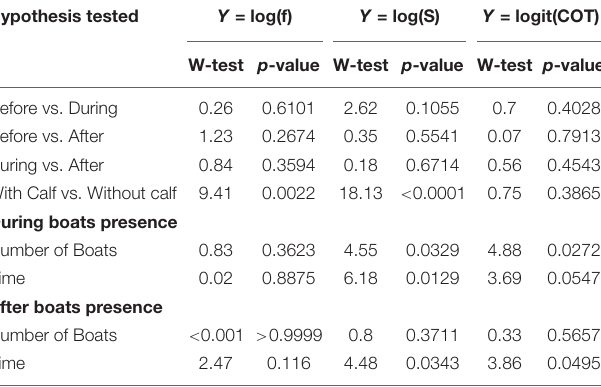
TABLE 3 | Wald-test and p -values for each the hypothesis tested for the models developed for breath frequency ( f ), swimming speed (S), and mass-specific cost of transport